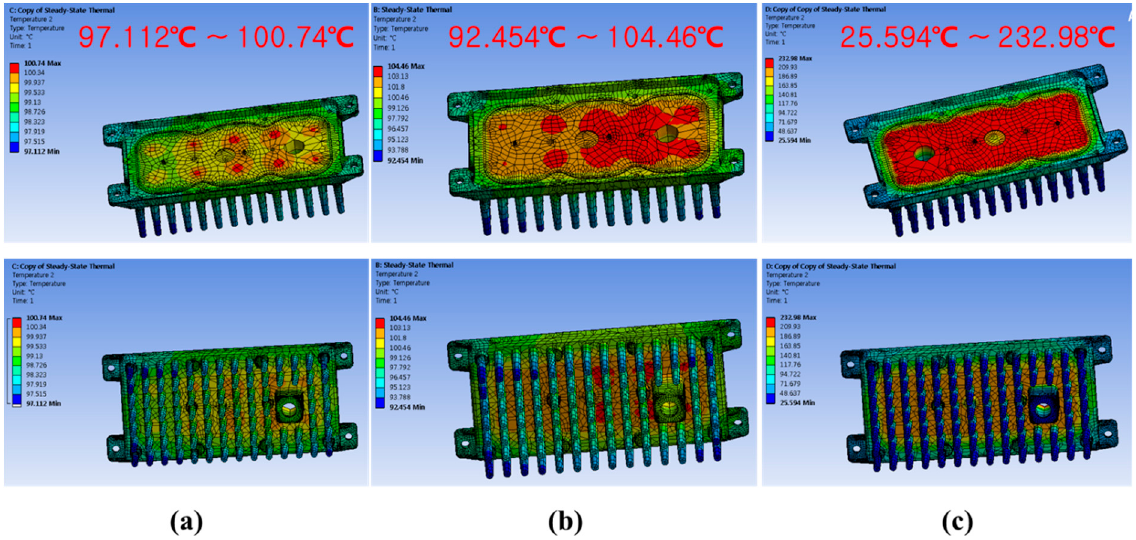
Figure 4. Thermal analysis simulations of product design; ( a ) aluminum materials, ( b ) polypropylene composites with hybrid carbonaceous fillers applied, ( c ) polymer materials.